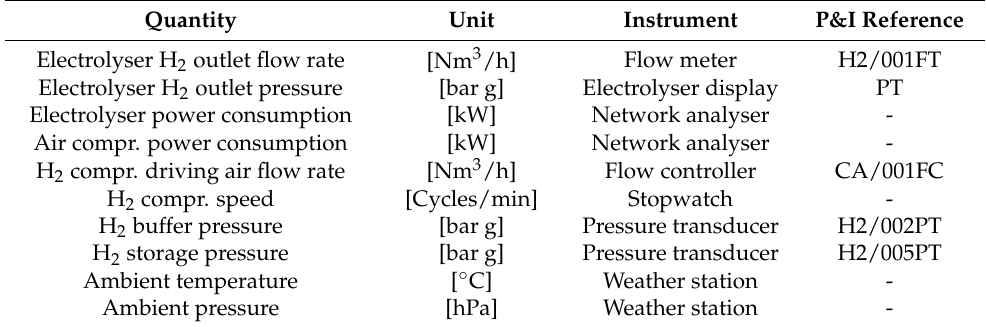
Table 10. Quantities measured during the hydrogen production and storage analysis test with unit of measurement, instrument used for the survey and reference to the position on the P&ID of Figure 2. Quantity Unit Instrument P&I Reference Electrolyser H 2 outlet flow rate [Nm 3 /h] Flow